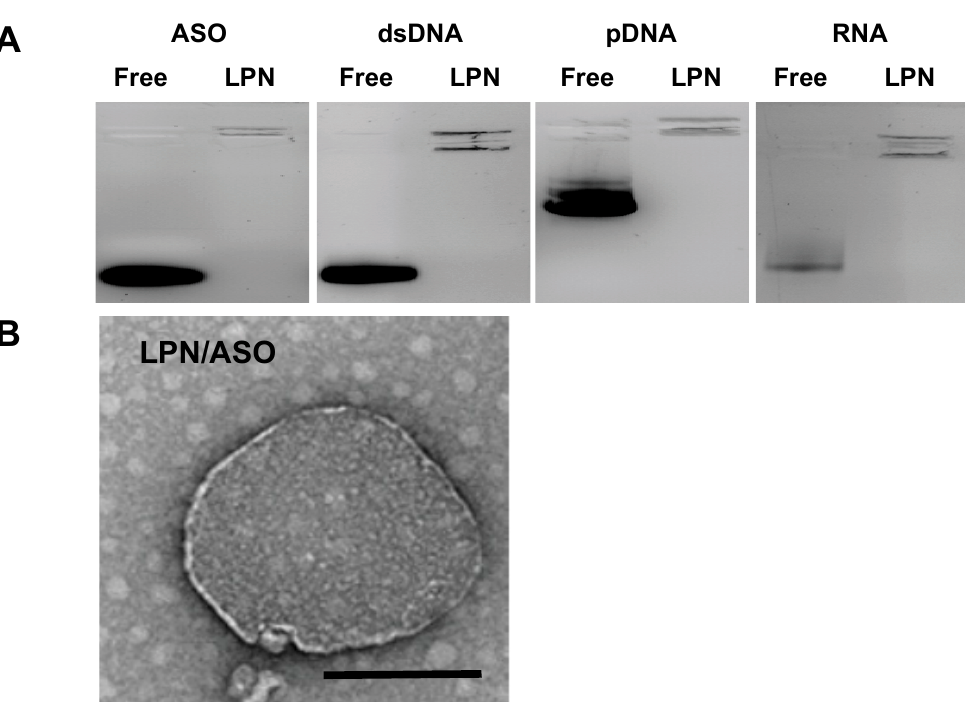
Figure 2. Characterization of LPN: ( a ) Gel retardation of nucleic acids either free or LPN-complexed. ( b ) Morphology of LPN–ASO complexes imaged by electron microscopy, scale bar represents 100 nm.